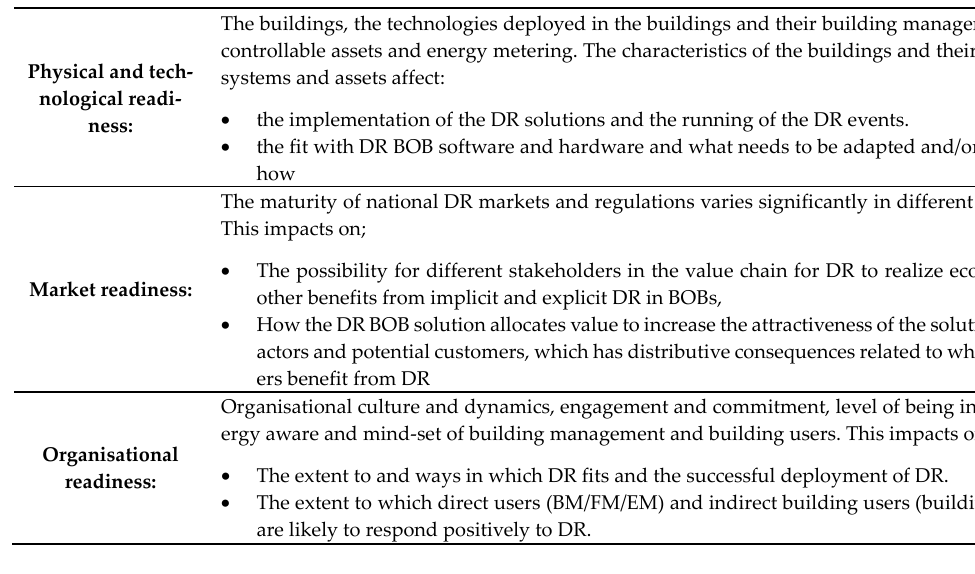
Table 1. Readiness